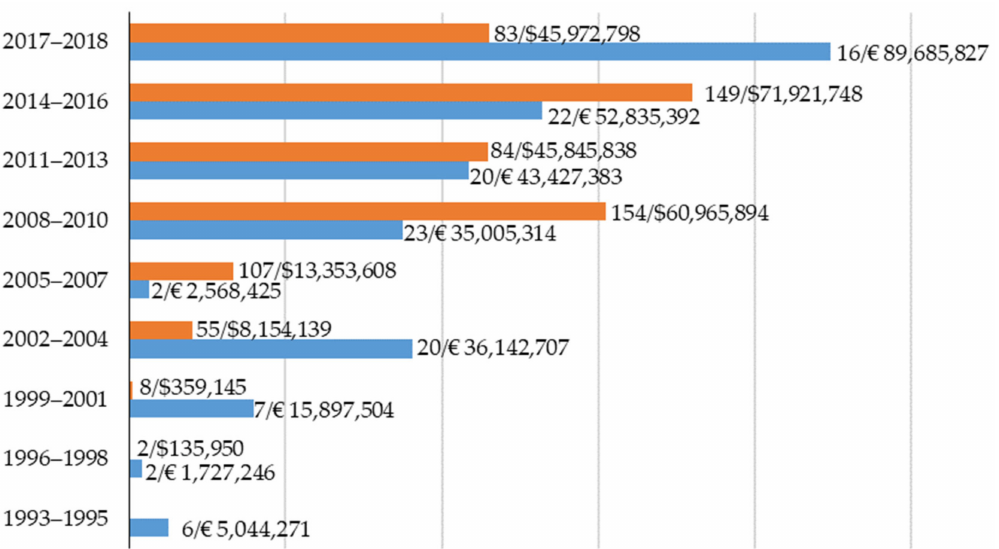
Figure 2. Number of projects and total funding by the European Commission (from 1993 to 2018; blue) and United States Department of Agriculture (from 1998 to 2018; orange) related to organic farming